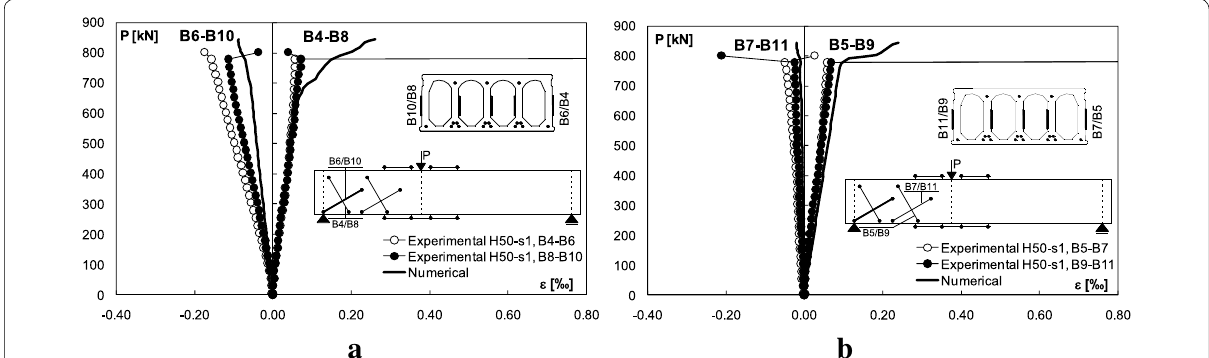
Fig. 16 Shear tests: comparisons between experimental and numerical results in terms of applied load P versus strain ε obtained from devices a B4-B8 (T) and B6-B10 (C); b B5-B9 (T) and B7-B11 (C) for specimen H50-s1.